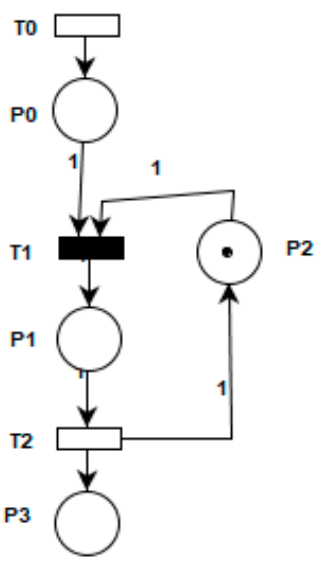
Figure 12. Petri net for a queue-server model.